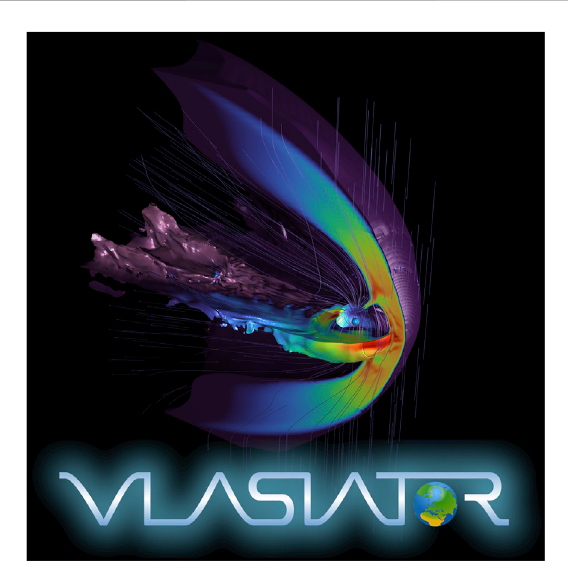
FIGURE 1 Relative performance of Vlasiator normalized to the performance inthe beginning of theproject. The target simulation isglobal,soincorporatingpartsofthesolarwindandalargepartof the magnetosphere. The black line gives the performance development of the world ’ s 500 top supercomputers. The blue and redareas give therelativeperformance ofVlasiatordepending on whether we used a local machine or a top European supercomputer available through Partnership for Advanced Computing in Europe (PRACE). The plot was made in 2016,